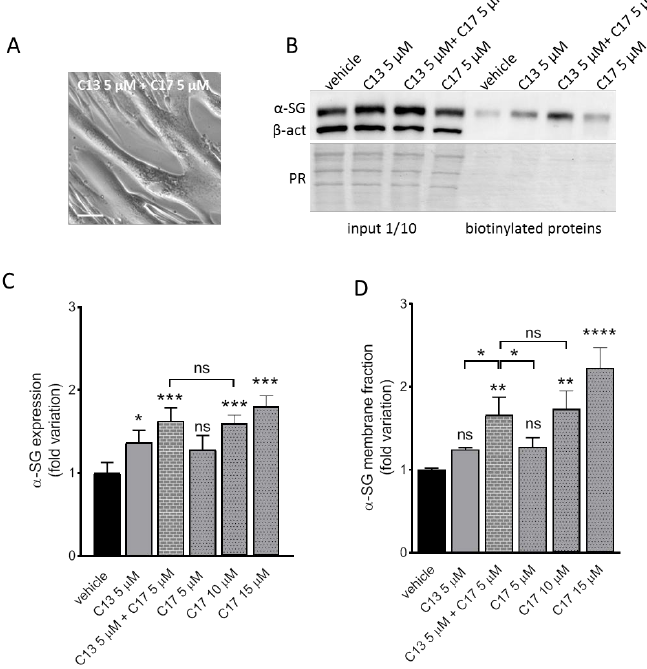
Figure 2. Additive effect of C13 in combination with C17. Myogenic cells from a patient carrying the L31P/V247M α-SG mutations were differentiated for 7 days and treated for the last 72 h with either 1‰ DMSO (vehicle), C13, C17 or C13 + C17 at the indicated concentrations. At the end of incubation, surface proteins were biotinylated. Then, myotubes were lysed and, after quantification, 50 µg of proteins were subjected to pull down assay by streptavidin-conjugated agarose beads. Recovered surface proteins and 1/10 of the starting myotubes lysates (input) were analyzed by SDS-PAGE and western blot with antibodies against α-SG and the cytosolic protein β-actin used as loading control (western blot of input) and to check the absence of biotin internalization (western blot of biotinylated proteins). ( A ) Phase contrast image showing the LGMD2D myotubes at the end of the combined treatment. Scale bar corresponds to 100 µm. ( B ) Representative western blot in which the left part shows the immunodetection of α-SG and β-actin present in the input lysates and the right part the fraction present at the sarcolemma; under the blot, the Ponceau Red staining of the membrane is reported as control of protein loading. Representative western blots of myotubes treated with vehicle, C17 10 µM or 15 µM is reported in Figure S2. ( C ) Quantification of α-SG content by densitometric analysis of the input and (D) of the biotinylated fraction of proteins. Values are the mean ( +/ − SD) of 3–4 independent experiments (each performed in duplicate) and are reported as fold increase of the amount present in the control sample. Statistical analysis was performed by One-way ANOVA test followed by multiple comparisons Tukey’s test; n.s., p > 0.05; *, p ≤ 0.05; **, p ≤ 0.01; ***, p ≤ 0.001, ****, p ≤